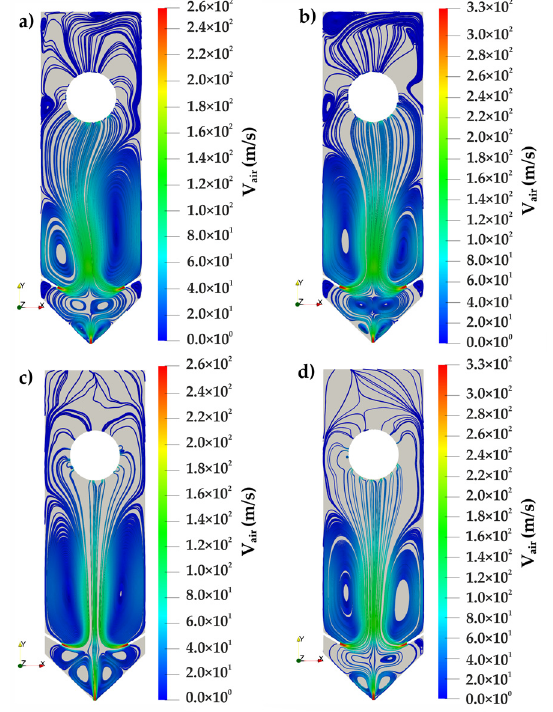
Figure 14. Streamlines based on the time-averaged air velocity as a function of the solid holdup and the nozzle inlet pressure: ( a ) 400 g and 0.5 bar; ( b ) 400 g and 1 bar; ( c ) 700 g and 0.5 bar; ( d ) 700 g and 1 bar.